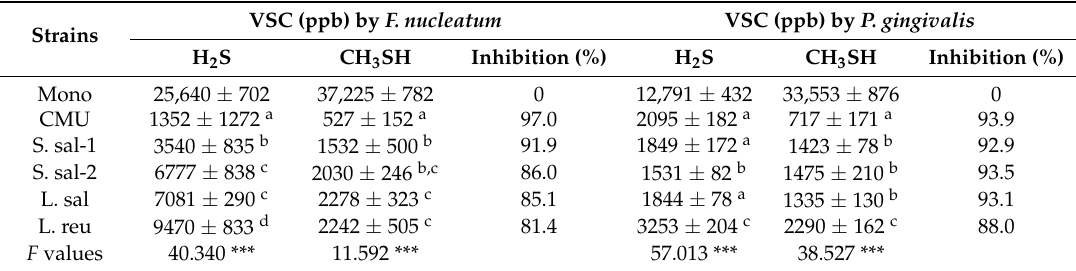
Table 6. Inhibitory effects of oral probiotic strains on the production of H 2 S and CH 3 SH by F. nucleatum and P. gingivalis